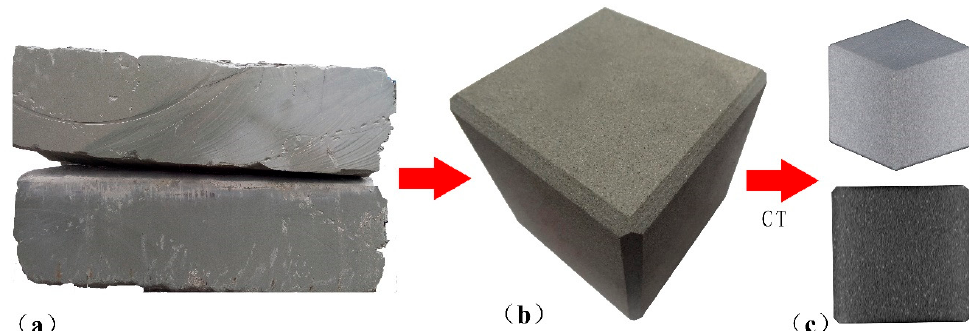
Figure 2. Photographs of sandstone specimens and computed tomography (CT) scan images. ( a ) raw rock sample’ ( b ) finished rock specimens; ( c ) finished sample CT images of cube ( upper ) and slice ( below ).